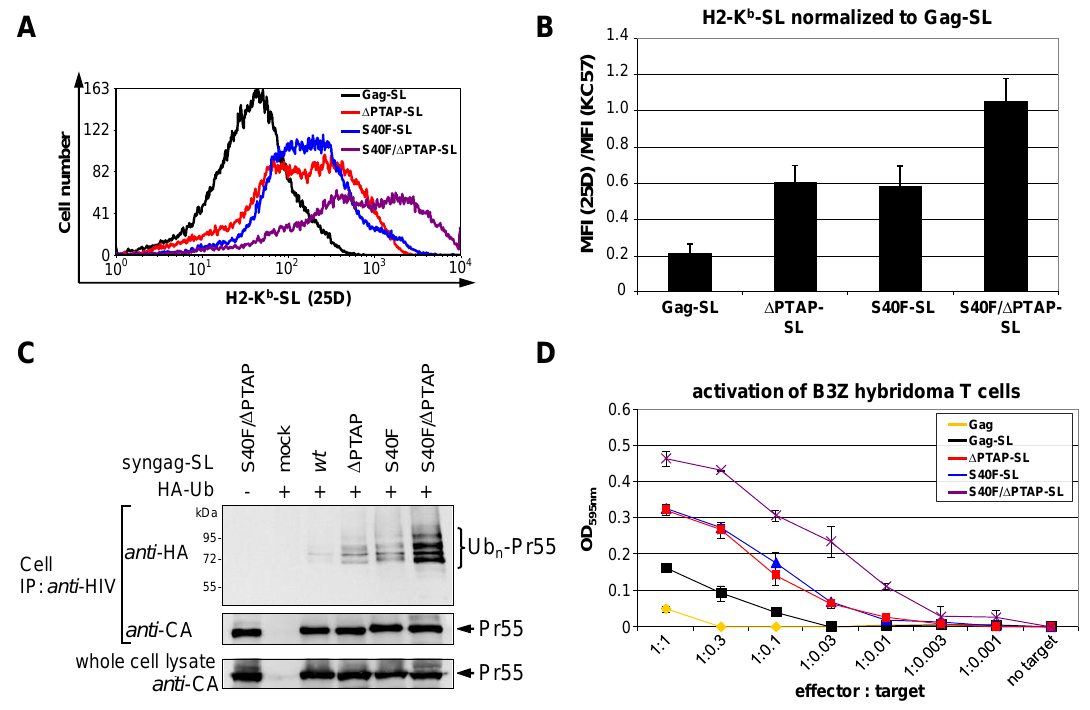
Figure 7. The S40F mutation induces an enhanced MHC-I antigen presentation of Gag derived epitopes. ( A ) HeLa-K b cells were transfected with syngag expression constructs coding for Gag-SL, ΔPTAP-SL, S40F-SL and S40F/ΔPTAP-SL. H2-K b -SL complexes presented on the surface of Gag-positive cells were quantified by flow cytometry using 25D1.16-APC. A representative histogram plot is shown; ( B ) Quantification of three independent experiments. The mean fluorescence intensity (MFI) of the 25D1.16 staining was normalized to the MFI of the intracellular anti- Gag staining obtained after permeabilization of the plasma membrane. Bars represent mean values ± SD; ( C ) Analysis of the Gag ubiquitination of the corresponding constructs. Gag was recovered from whole cell lysates by immunoprecipitation using anti- HIV antibodies, and ubiquitinated species were detected by anti-HA staining; ( D ) Activation of B3Z hybridoma T cells was assessed by a colorimetric β-galactosidase assay after overnight cocultivation with HeLa-K b cells expressing Gag wt , Gag-SL wt , ΔPTAP-SL, S40F-SL or S40F/ΔPTAP-SL in various effector-to-target